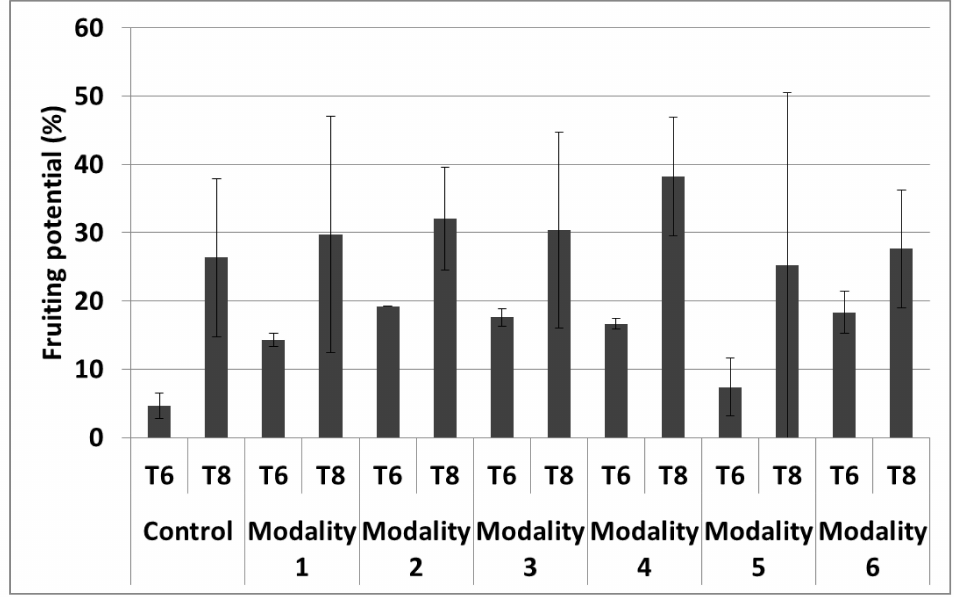
Figure 10. Evolution at T6 and T8 of the fruiting potential in % (percentage of flowers, wilted Figure 1. = AMF (strain IP21); modality 2 = AMF (strain IP21) + Trichoderma harzianum ; modality 3 = AMF (strain IP21) + Pseudomonas fluorescens (strain IPB04); modality 4 = AMF (strain IP21) + Trichoderma harzianum + Pseudomonas fluorescens (strain IPB04); modality 5 = commercial AMF product containing 6 AMF strains; modality 6 = commercial AMF product containing 6 AMF strains + Trichoderma